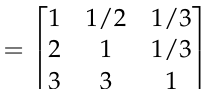
Figure 19. AHP hierarchy.